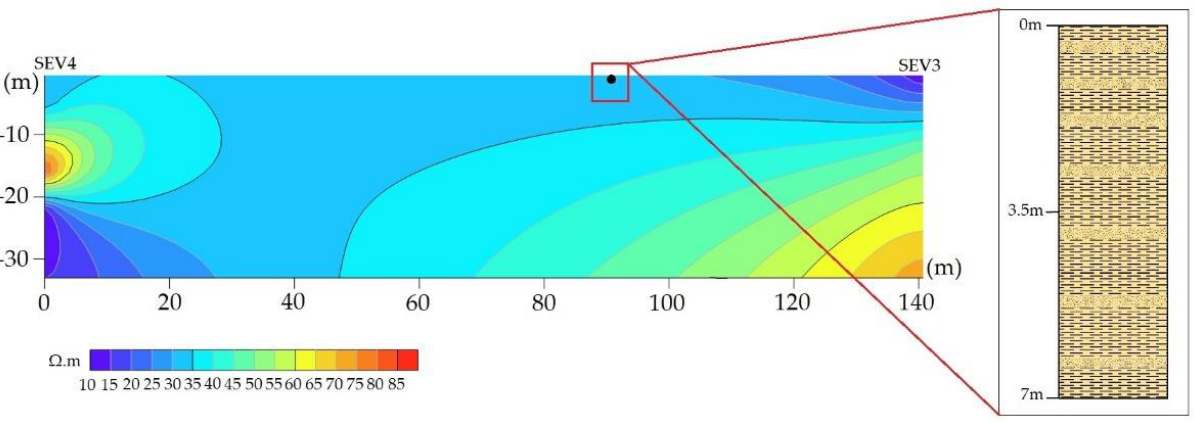
Figure 7. Correlations between the VESs (4-3) and drilling D1. It can be seen that the material obtained from drilling D1 (shales) coincides with the resistivity presented (values between 35.0 and 40.0). Table 11. Physical–mechanical properties of rock samples from geomechanical stations. Station